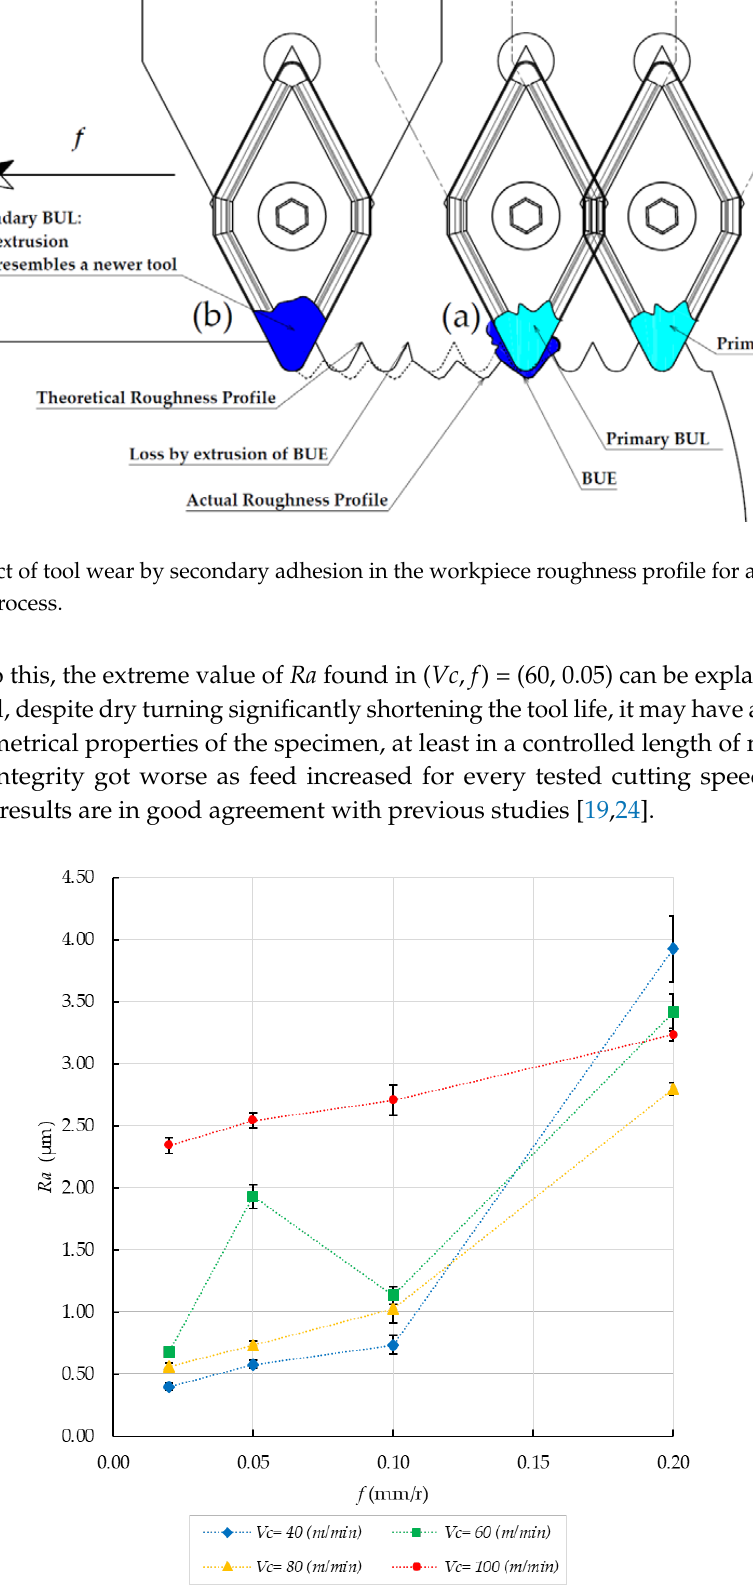
Figure 6. Evolution of Ra / f for all the cutting speeds studied. Error bars show the statistical standard deviation.